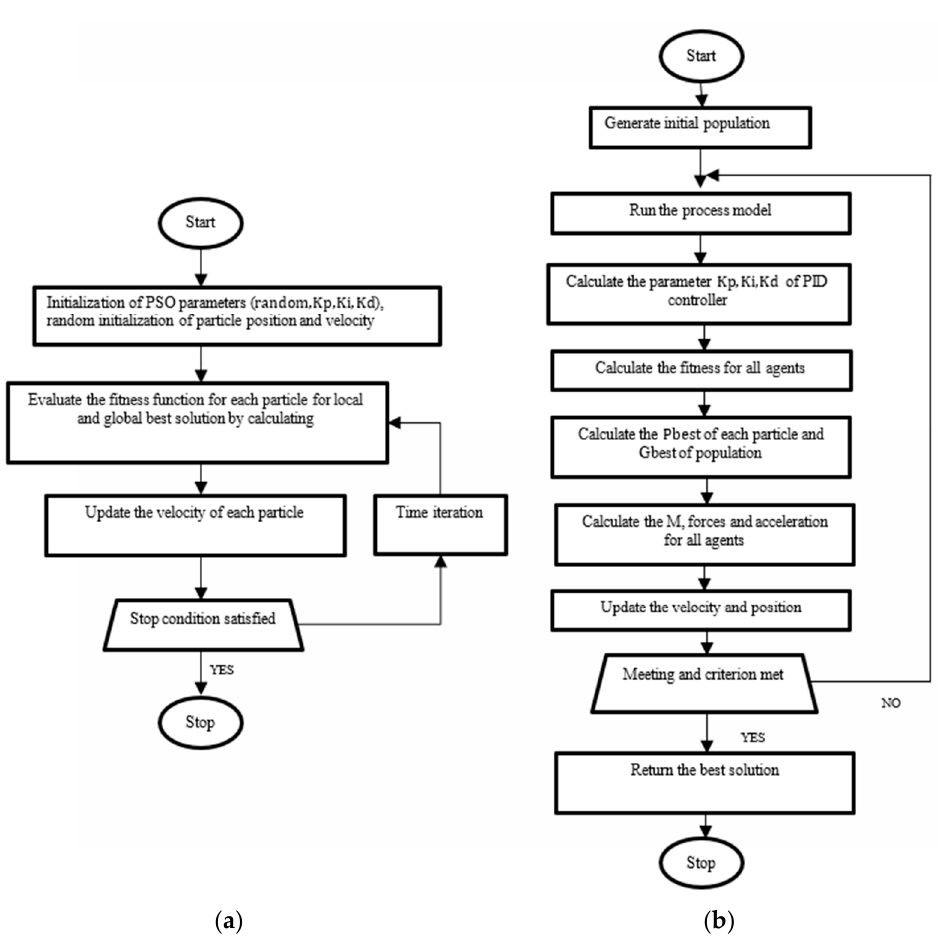
Figure A1. Flow diagram of the proposed intelligent tunning algorithm for adjusting the PID gains using combinatorial optimization: ( a ) Flowchart of PSO algorithm, ( b ) Flowchart of PSO–GSA algorithm).